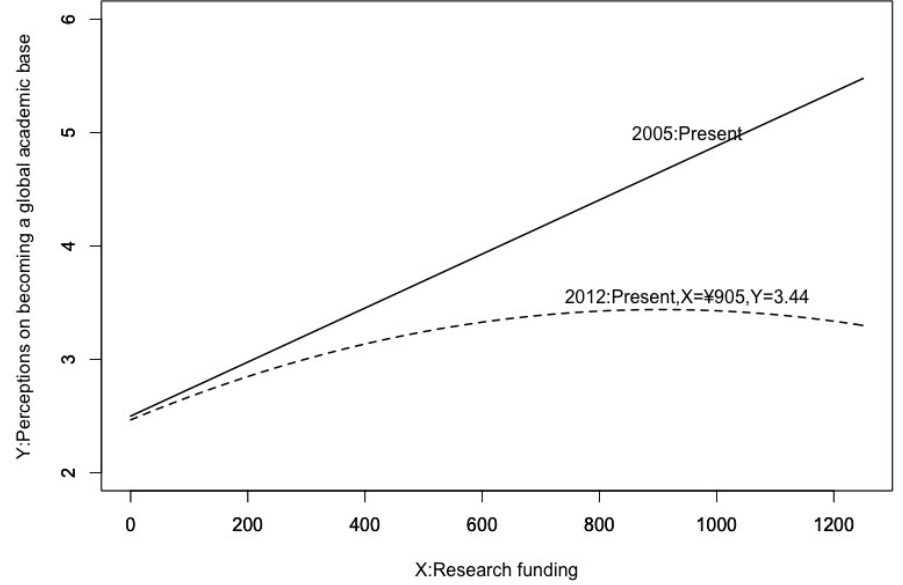
Figure 3. Self-assessment of Japanese university executives on becoming a global academic base and the total amount of research